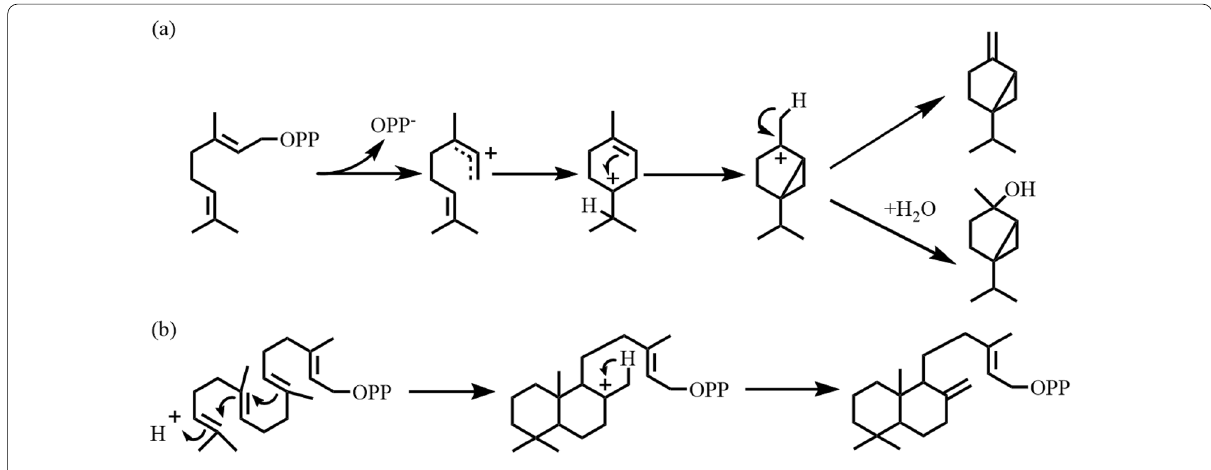
Fig. 2 Different formation mechanisms of carbocation in class I and class II terpene cyclases. a Ionization‑dependent reaction catalyzed by class I terpene cyclases with GPP as the substrate. b Protonation‑dependent reaction catalyzed by class II terpene cyclases with GGPP as the